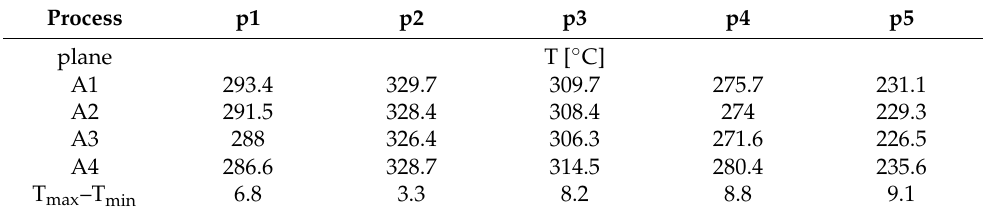
Table 10. Temperatures in planes A1, A2, A3 and A4 at the time at which the greatest differences in temperature values along the cylinder length occurred.